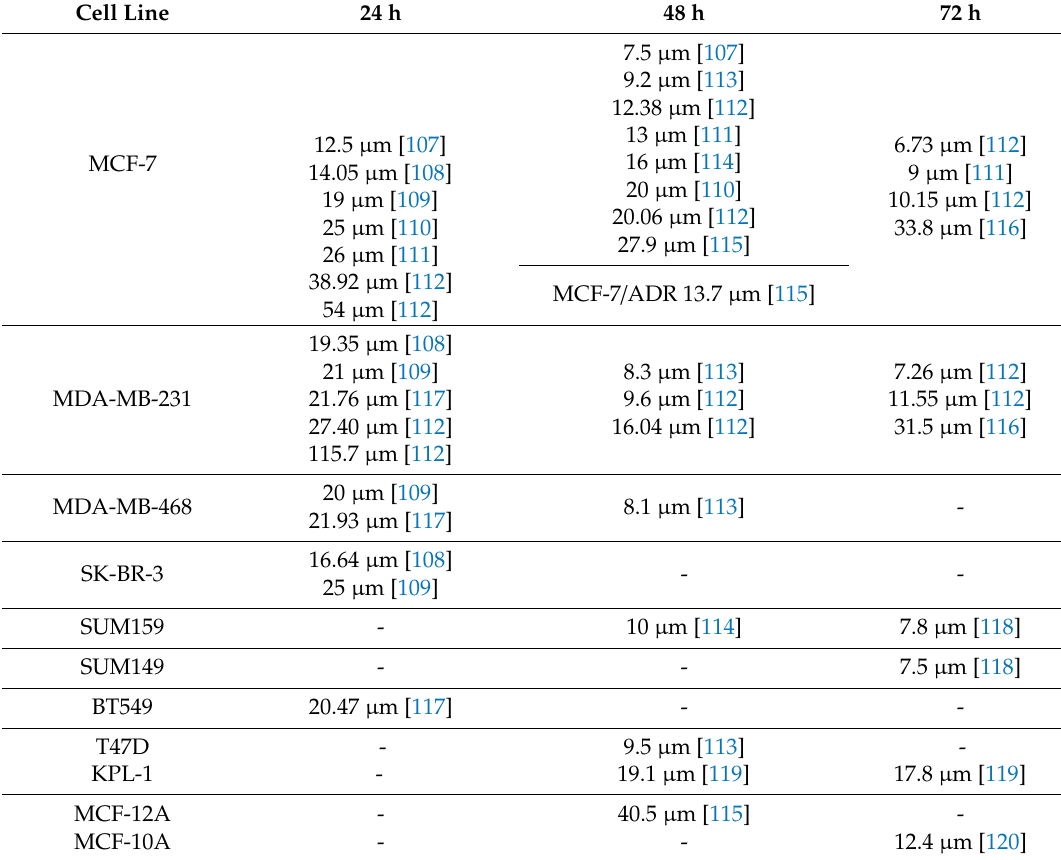
Table 4. IC 50 values for breast cancer and normal cell lines after 24 h, 48 h and 72 h of incubation with